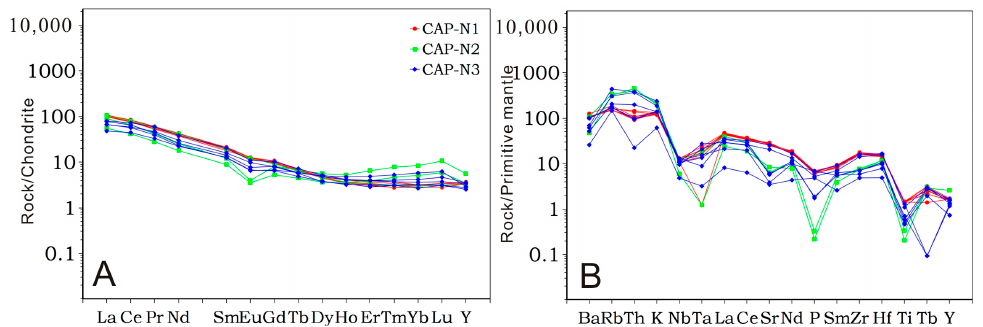
Figure 4. ( A ) Chondrite normalized REE pattern; ( B ) primitive mantle normalized trace element spider diagram of monzogranite in the Chang’anpu porphyry Mo deposit (Sun and McDonough, 1989)